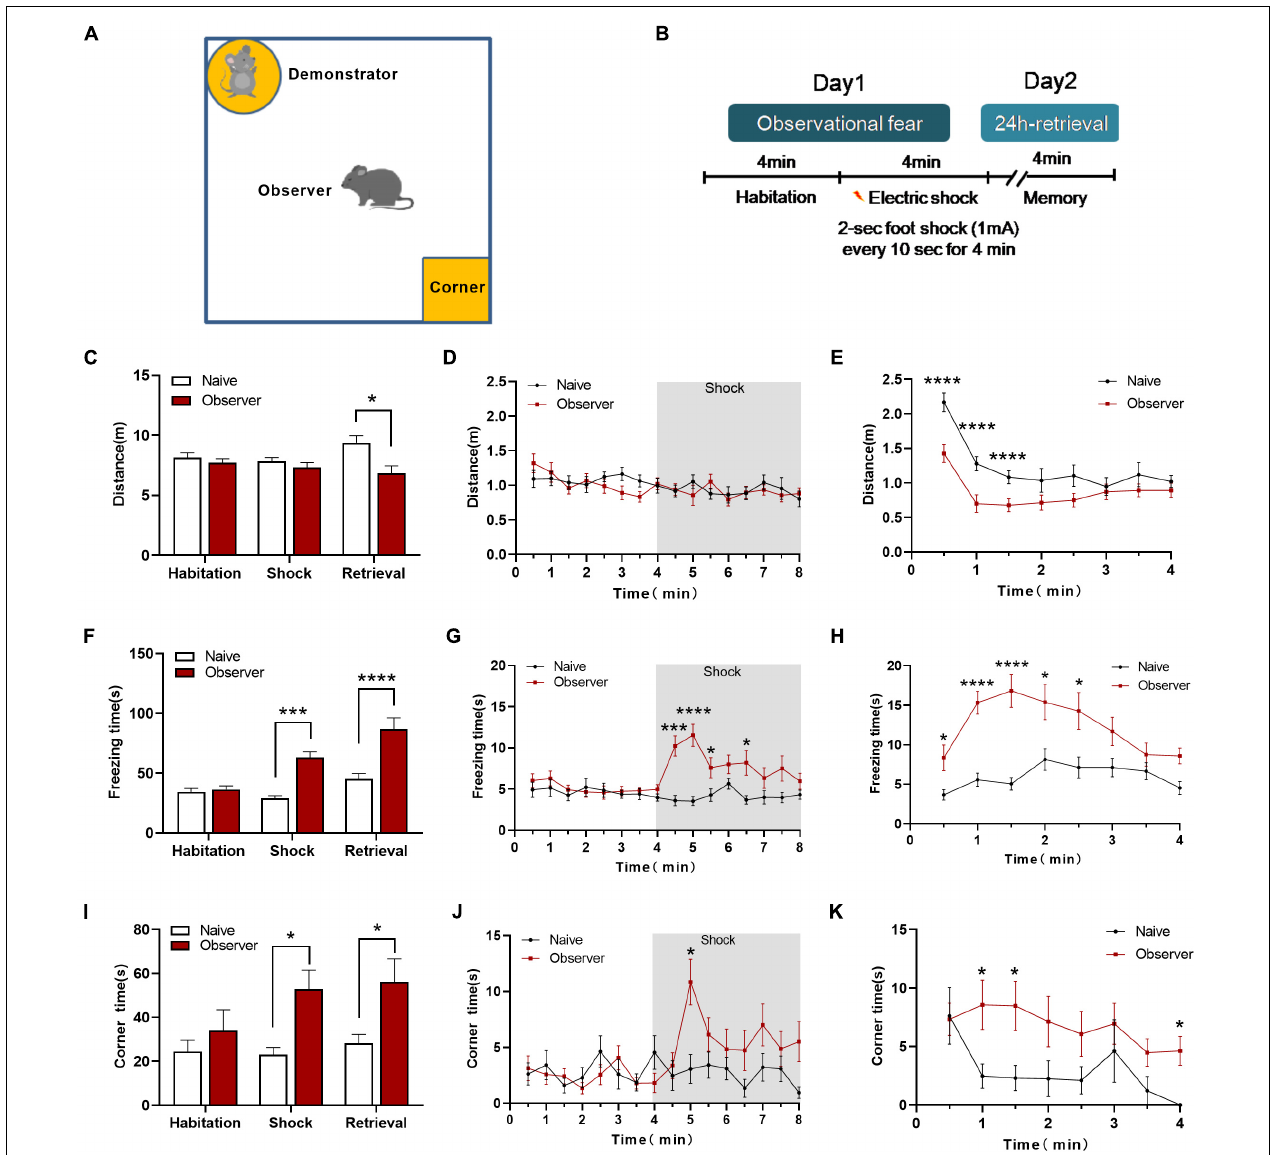
FIGURE 1 | The psychological stress-related behaviors of observational fear learning model. (A) Diagram of the observational fear chamber; (B) Outline of the observational fear behavioral paradigm; (C) Distance moved in the chamber of naïve and observer mice during three phases. (D) The variation of distance during Day 1. (E) The measurement of distance during 24-h retrieval phase. (F) Vicarious freezing of naïve and observer mice during three phases. (G) The variation of vicarious freezing time during Day 1. (H) The measurement of freezing time during 24-h retrieval phase. (I) Time spent in the corner zone of naïve and observer mice during three phases. (J) The variation of corner time during Day 1. (K) The measurement of corner time during 24-h retrieval phase; Data are shown as mean ± SEM (naïve n = 13, observer n = 16) and compared by two-way ANOVA analysis followed by Sidak’s multiple comparisons test, * p < 0.05, *** p < 0.001, **** p < 0.0001, vs.